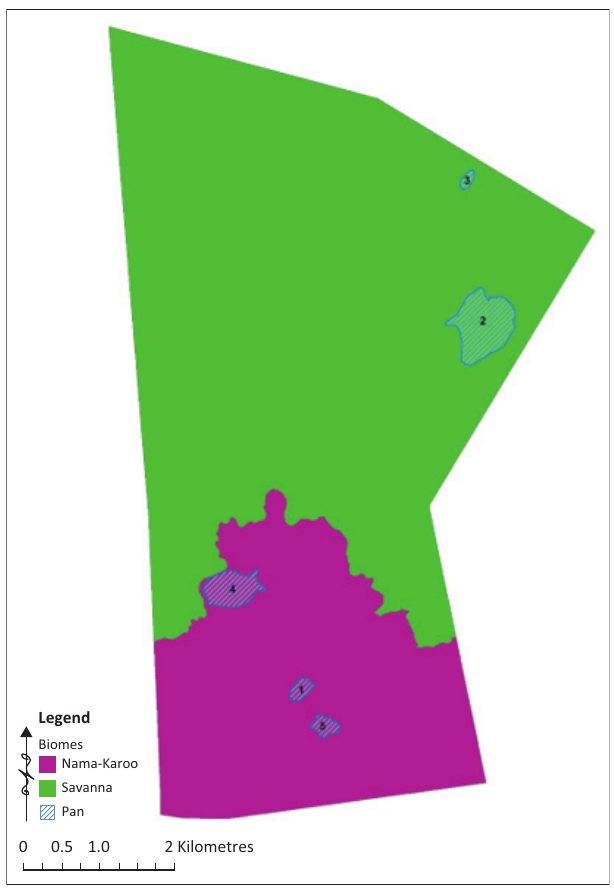
FIGURE 2: Localities of pans in Gras-Holpan, where the north falls in the savanna biome (Pans 2 and 3) and south in the Nama-Karoo biome (Pans 1, 4 and